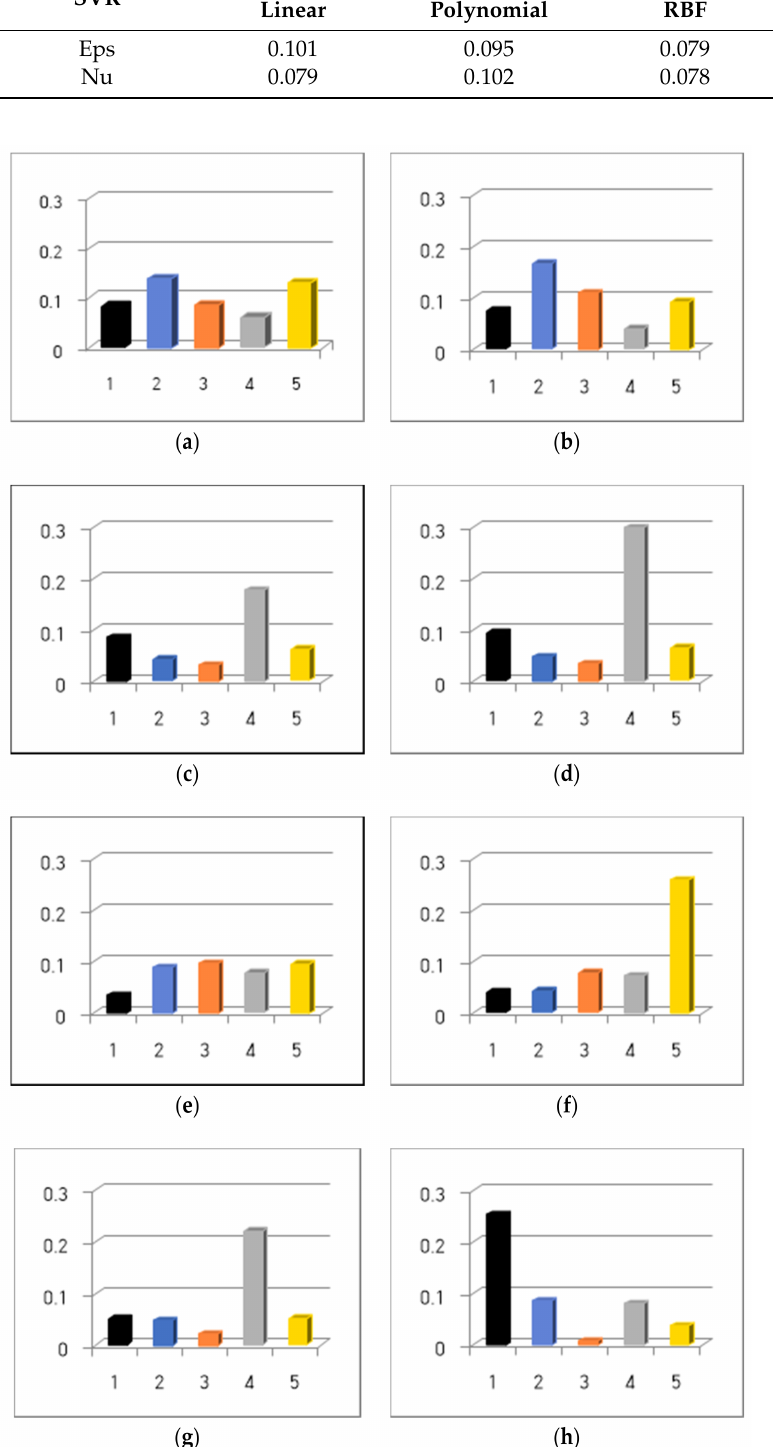
Figure 2. Five-fold cross-validation results of the dementia severity predictive model by the